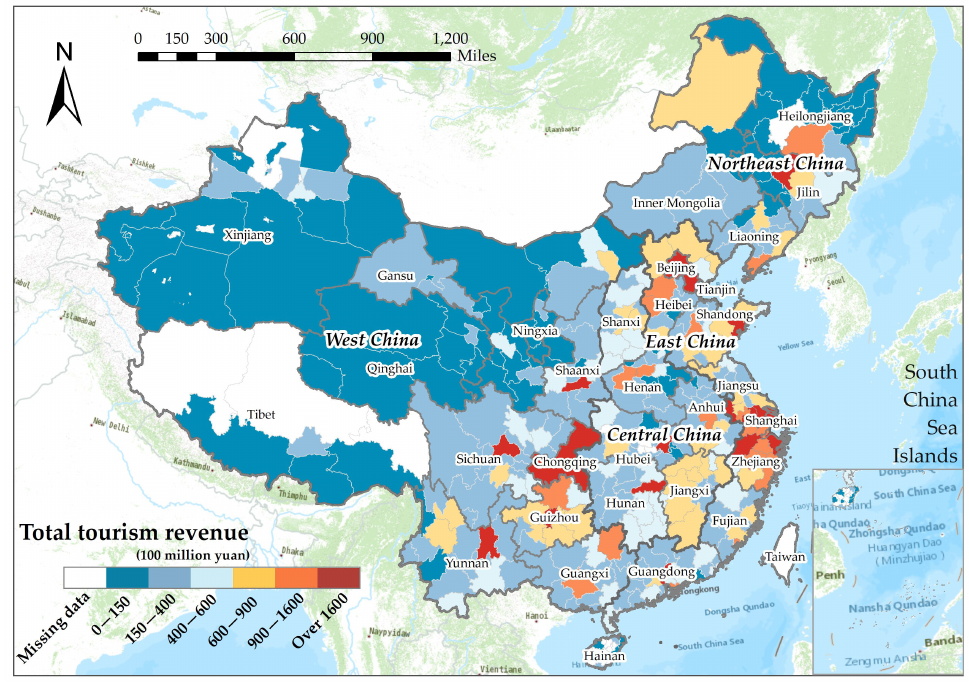
Figure 1. Geographical distribution of the original city-level total tourism revenue across China in